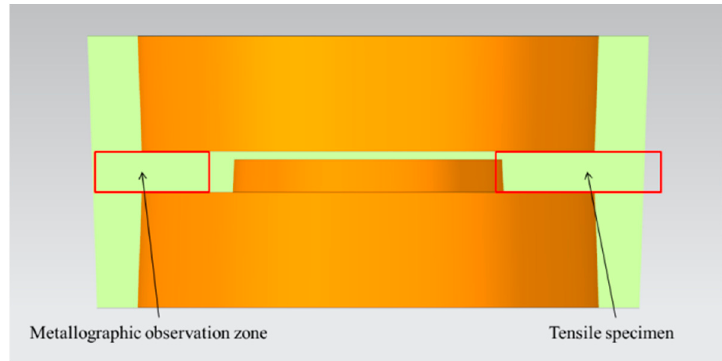
Figure 4. Metallographic observation surface and sampling position of tensile specimen.